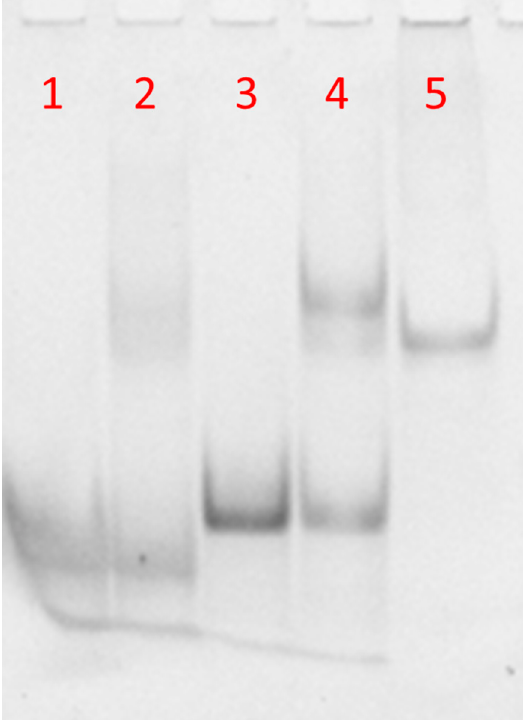
Figure 3. PAGE of DNA-FAM or DNA annealed with PNA in 100 mM PBS solution. Lane 1: DNA alone; lane 2: DNA/PNA mixture; lane 3: DNA FAM alone; lane 4: DNA FAM/PNA mixture, lane 5: 23-bp duplex DNA marker.